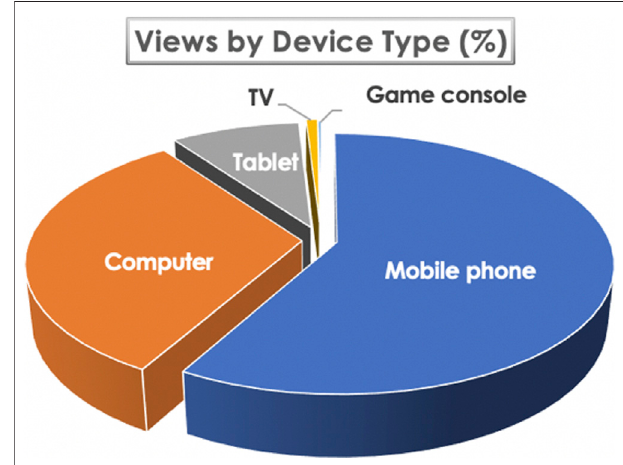
FIGURE 9 | Playback devices used to view